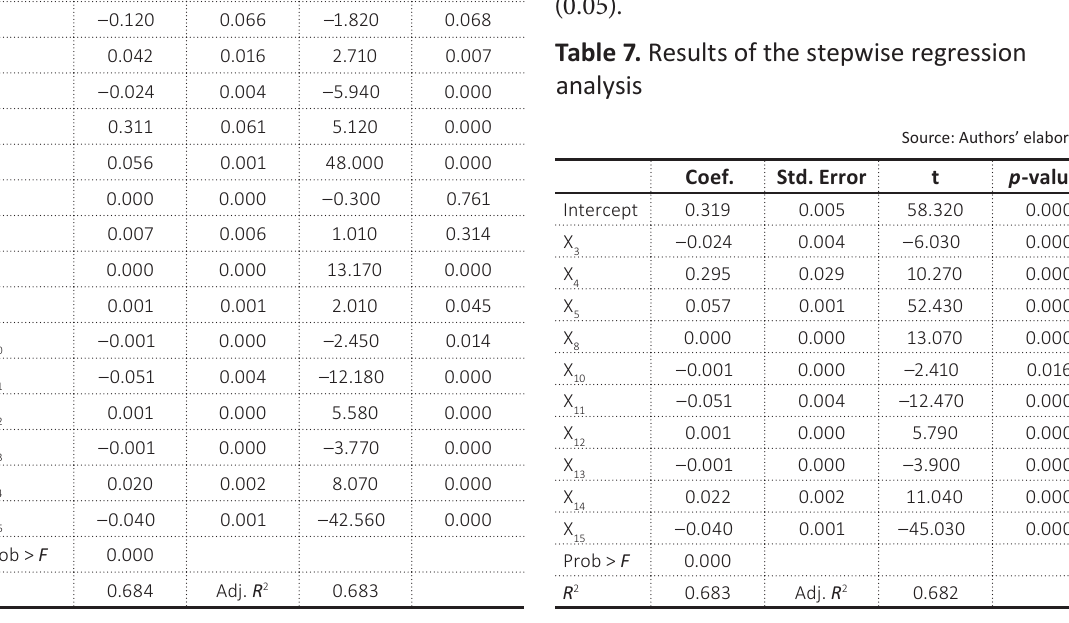
Table 7. Results of the stepwise